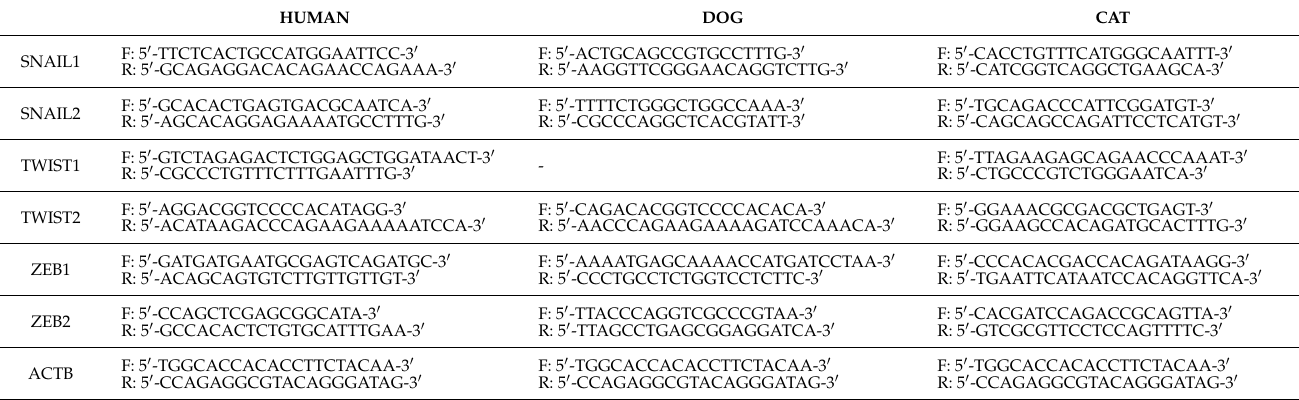
Table 1. Primer sequences used in this